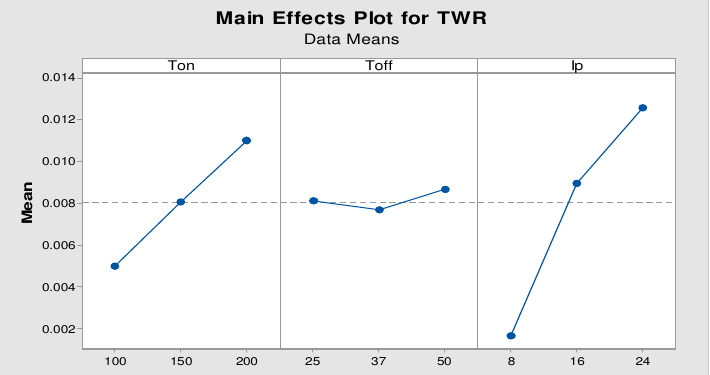
Fig. 3. MRR Main Effects Plot.